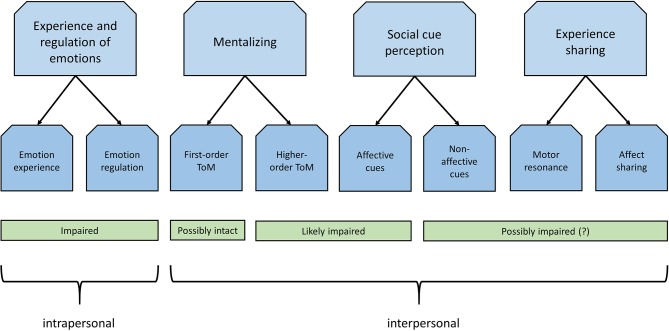
Schematic overview of social cognitive alterations in obsessive-compulsive disorder with regard to the domains discussed in the current review, based on Green et al. (4). These domains can be divided in intrapersonal and interpersonal domains. Much research has been conducted on the intrapersonal domain, providing strong evidence from neuroimaging studies for altered emotion experience and impaired emotion regulation. Evidence with regard to the interpersonal domain however is limited and less consistent. Affective cue perception is likely impaired, specifically with regard to the recognition of facial expressions of disgust. Similarly, there is evidence for theory-of-mind (ToM) impairments especially with regard to higher-order inferences. There is also some evidence for impaired perception of nonaffective cues, although research is scarce. Studies on experience sharing are lacking, though there are some indirect indications that these domains may be affected as well.